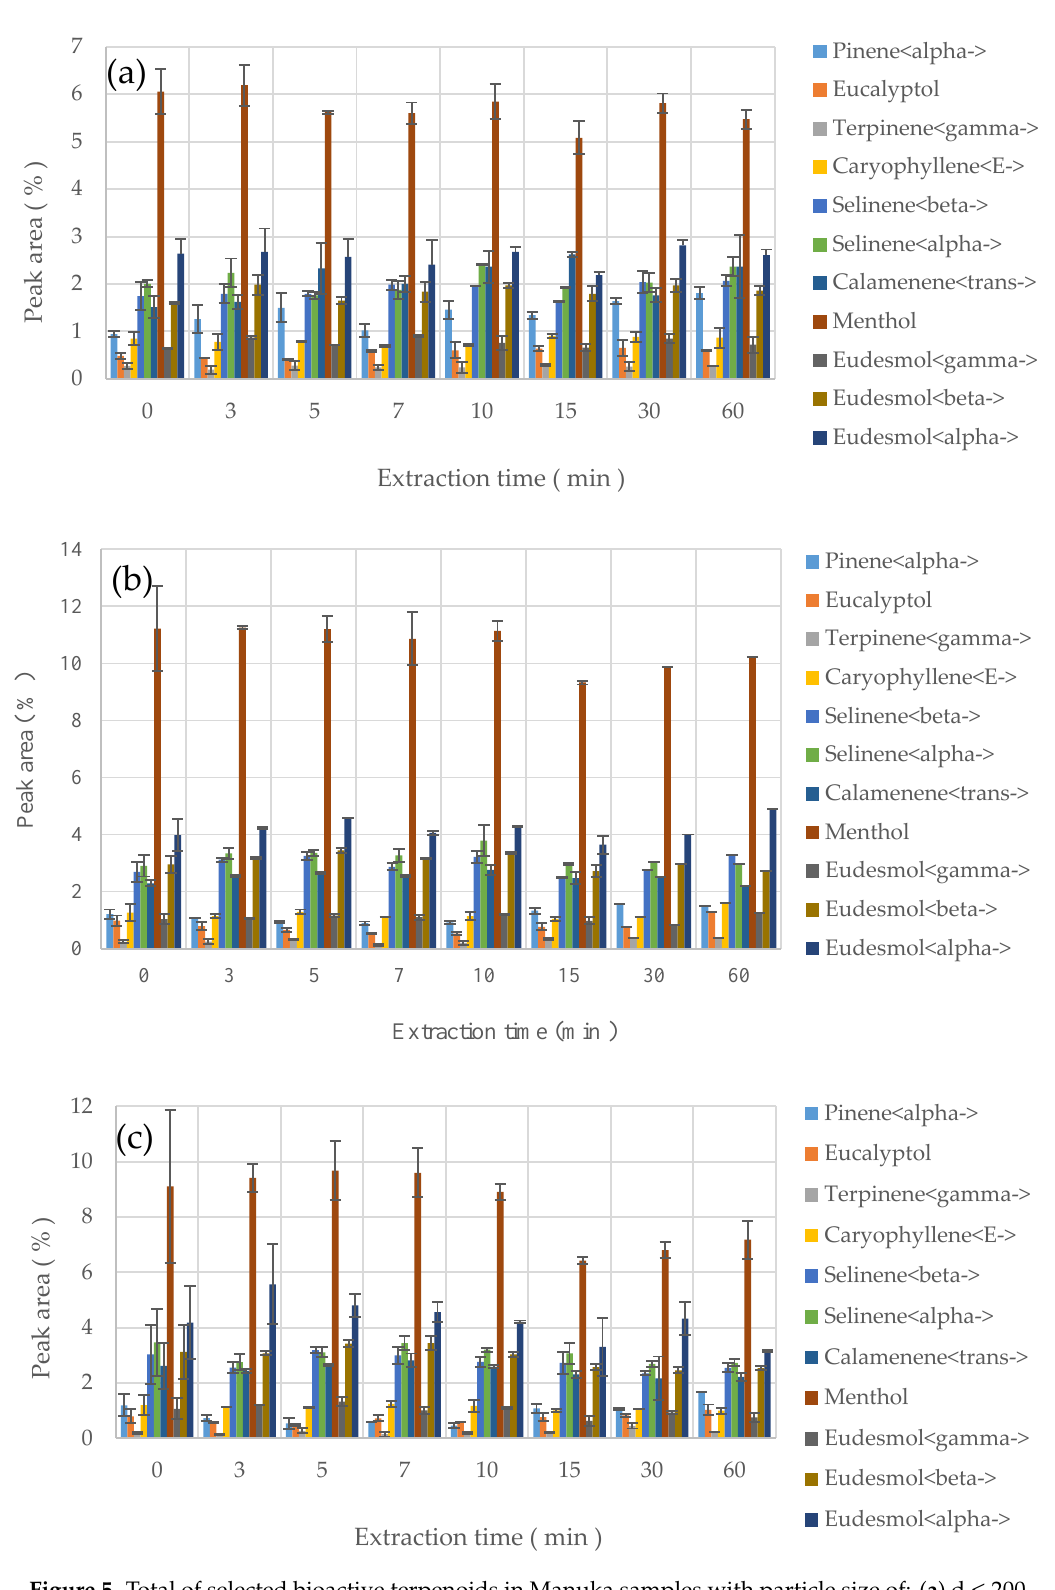
Figure 5. Total of selected bioactive terpenoids in Manuka samples with particle size of: ( a ) d ≤ 200, ( b ) d = 100 μm, ( c ) d = 68 μm.